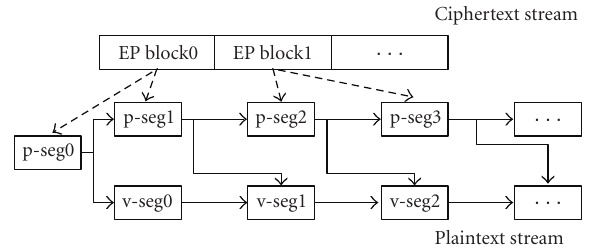
Figure 2: Image codestream format after selective